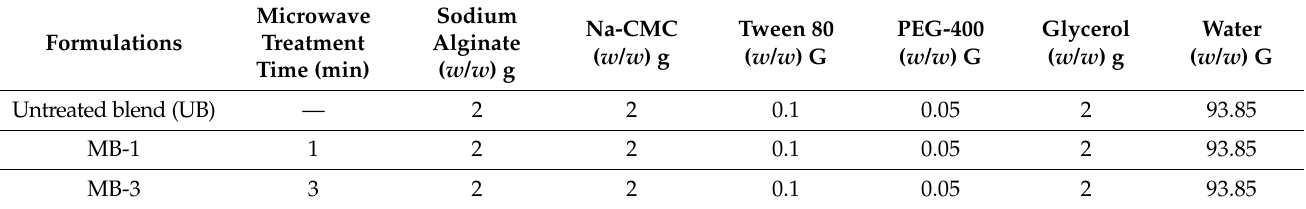
Table 1. Composition of modified blended sodium alginate and sodium CMC film